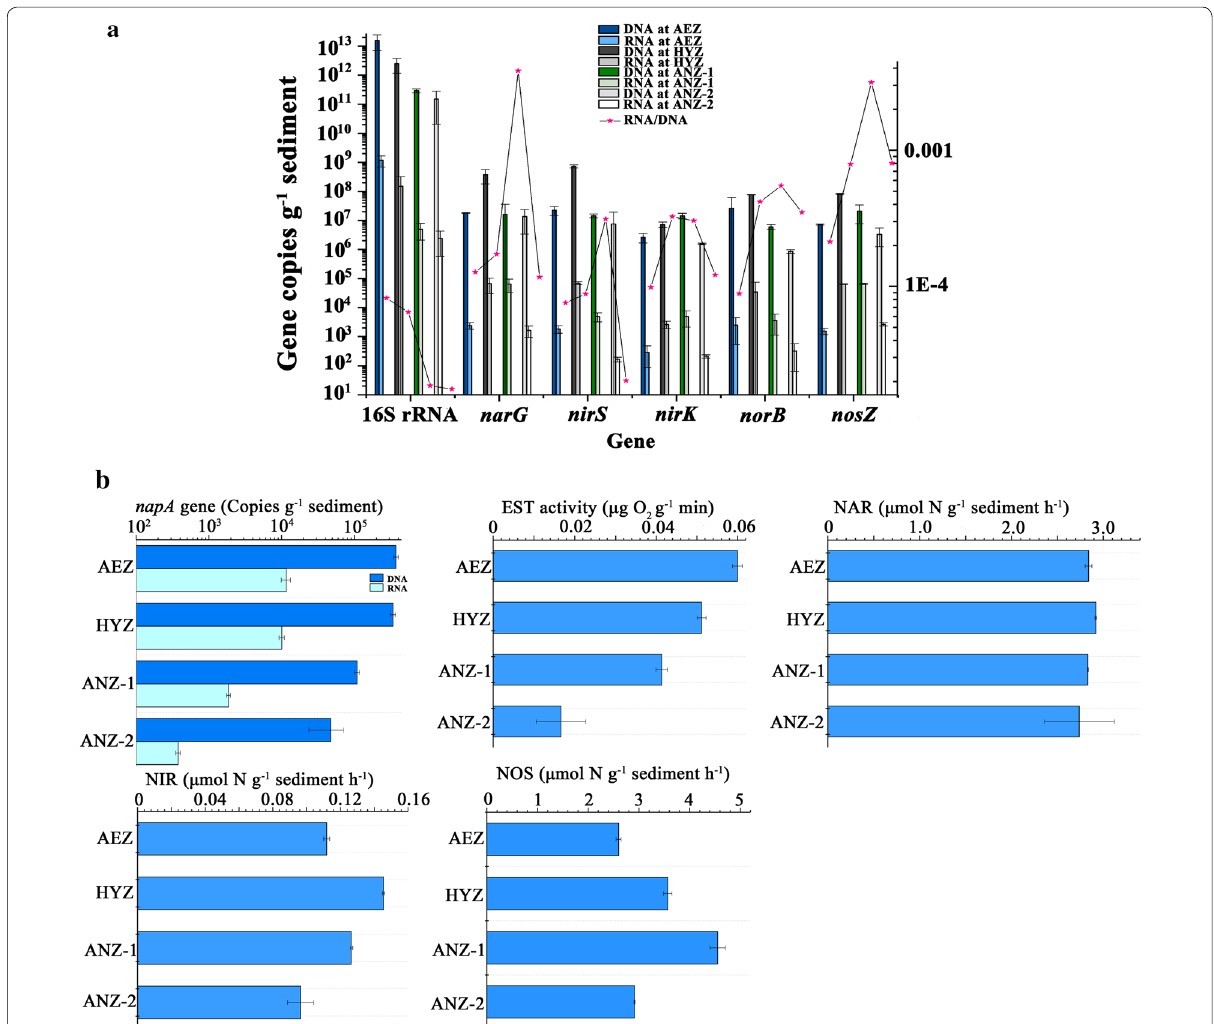
Fig. 3 a Copies of 16S rRNA, narG , nirK , nirS , norB and nosZ genes per gram of sediment at DNA level, RNA level and their ratios (ratio of copies at RNA level to that at DNA level for each gene, RNA: DNA). b Copies of napA gene per gram of sediment, activities of electron transport system (ETS) and denitrifying enzymes at different layers of sediments. Error bars indicate standard errors of three replicates. NAR nitrate reductase, NIR nitrite reductase, NOS nitric oxide reductase, AEZ aerobic zone, HYZ hypoxic zone, ANZ-1 up-anoxic zone, ANZ-2 sub-anoxic